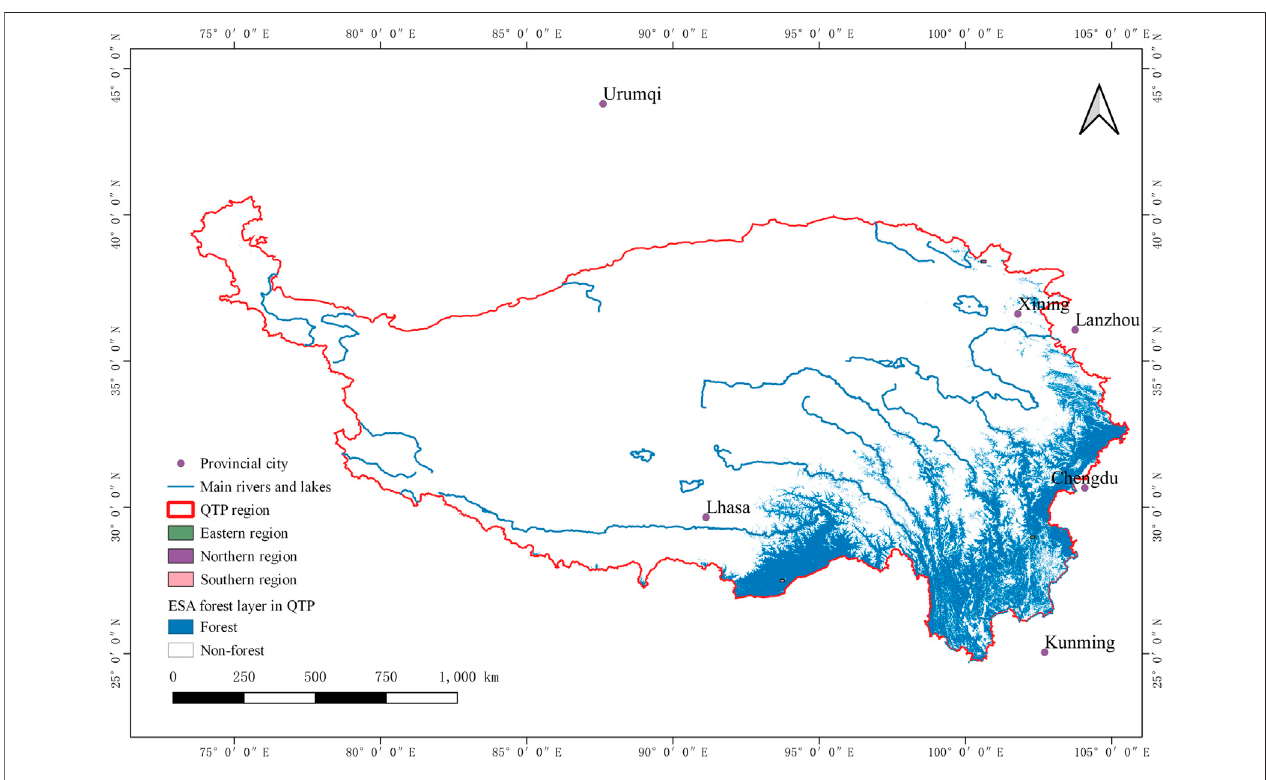
FIGURE 10 | Forest layer of ESA WorldCover